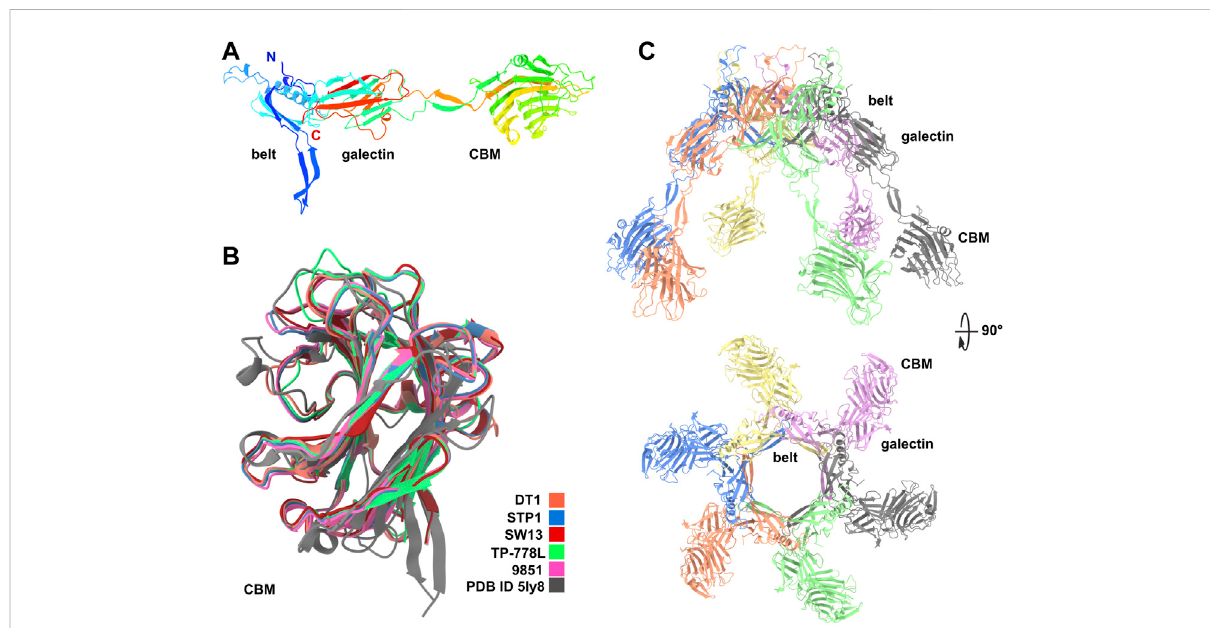
FIGURE 1 Predicted structure of Dits. (A) Ribbon representation of TP-778L Dit monomer with its three domains, belt, galectin and CBM (rainbow colored). (B) Ribbonrepresentationofthesuperimpositionofthe fi veDitCBMstogetherwiththeDali ’ sbesthit[PDBID5ly8; Lactobacillus phageJ-1 Dit CBM (Dieterle et al., 2017)]. (C) Ribbon representation of the TP-778L Dit hexameric assembly (orthogonal views). The top loops are poorly predicted and are suspected to interact with the most distal major tail protein (MTP) ring (colored by